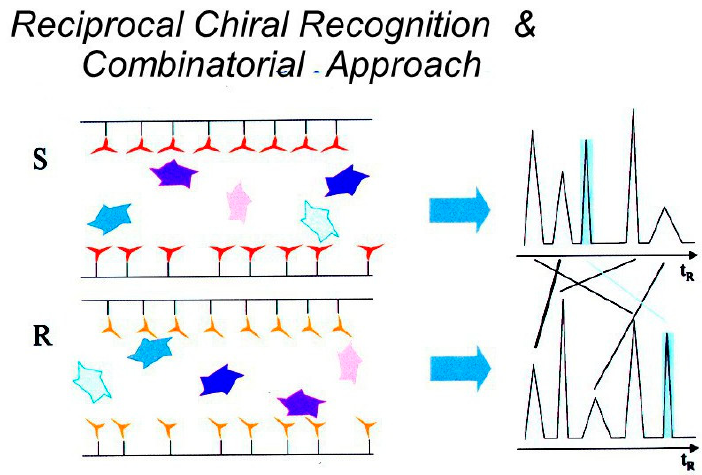
Figure 10. Illustration of the identification of an optimal selectand in a small library exhibiting the highest enantioselectivity toward a chiral selector used either in the S - or R -configuration as revealed by the largest difference of its retention (earmarked by the pale blue colour at the right).